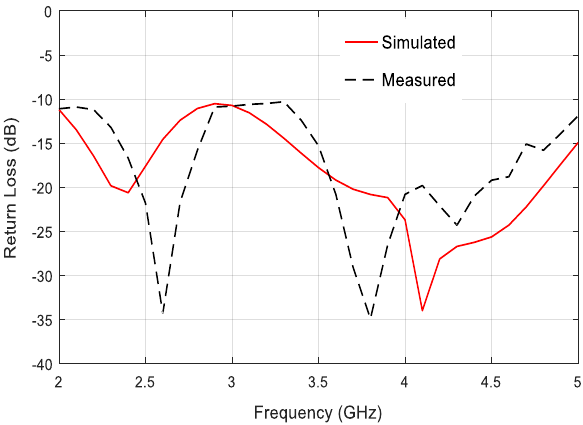
Figure 5. Simulated and measured return loss curves.